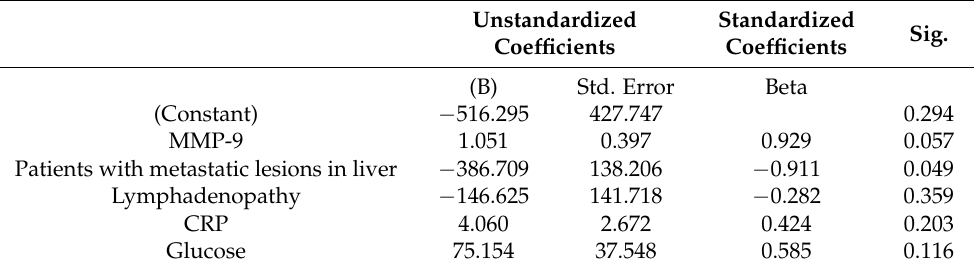
Table 3. Association MMP-9 values after PBD procedure with clinical parameters (multivariate linear regression